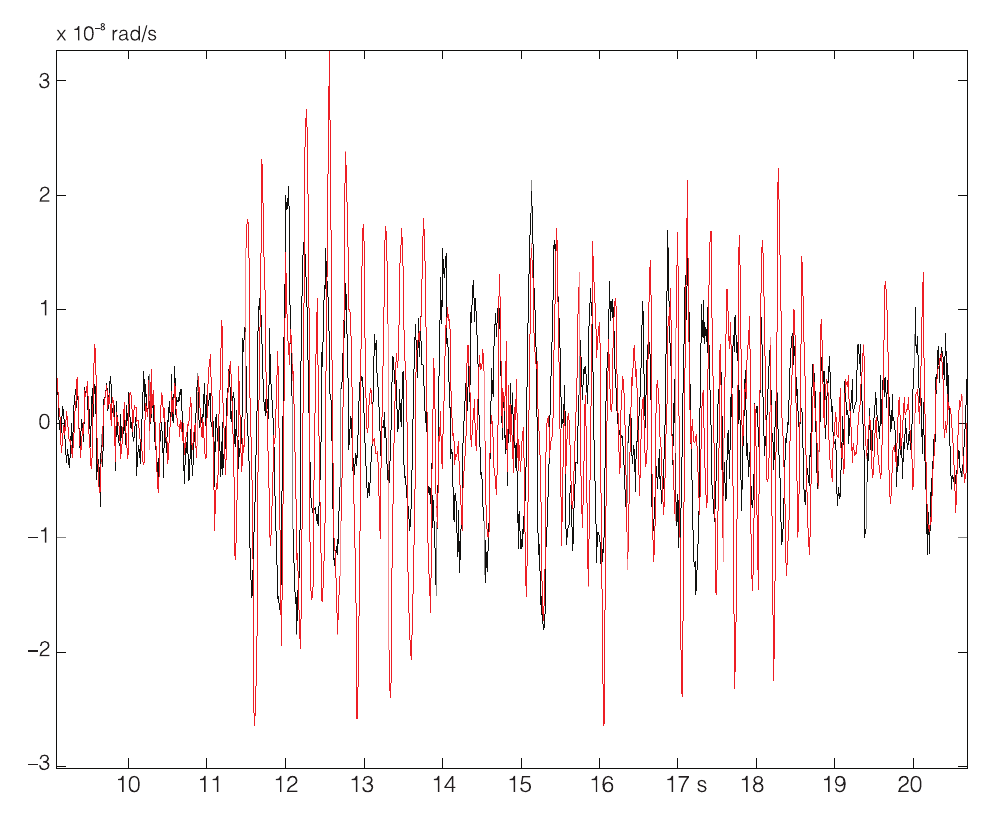
Fig. 11. Comparison between the observed micro-displacement velocity fi eld (black curve) and the estimated derivative of displacement velocity (red curve) with the appropriately chosen apparent wave velocity for the best fi t of both curves (here V = 50 m/s); the correlation coeffi cient equals to 0.5 (Ojcow Observatory; as